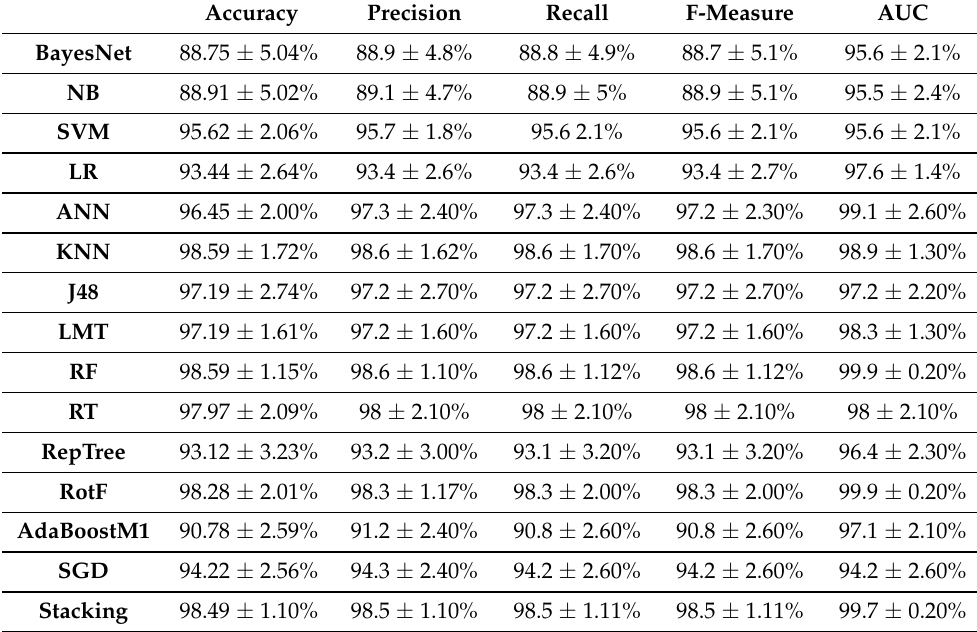
Table 4. Performance evaluation after SMOTE with 10-fold cross-validation.